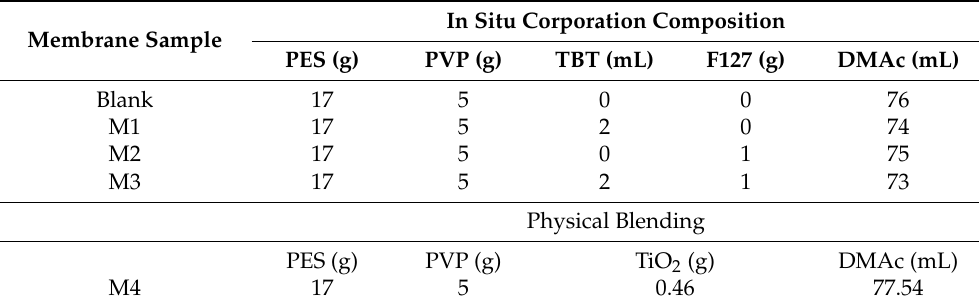
Table 1. Dope solution composition with different additives and mixing